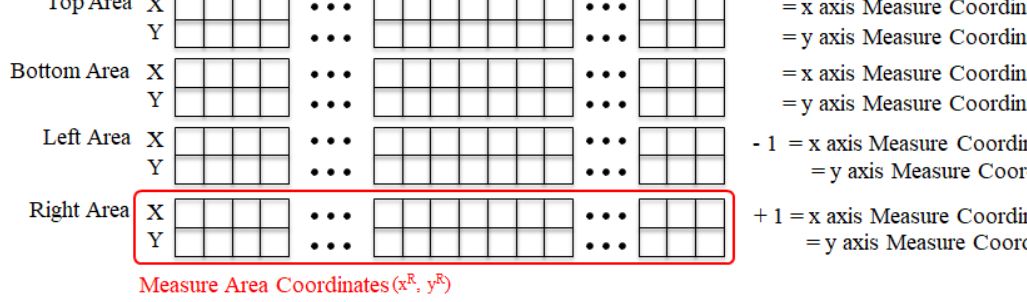
Figure 13. Reference point extraction method (lower-right area). ( a ) Right-hand search area of the circular coordinate array. ( b ) Successful search. ( c ) Search continued. The pseudocode for searching the lower-right area based on the circular coordinate array is shown in Figure 14, where the coordinate array carray[i, len] is used as the input parameter. The values x and y are set to one of coordinates of the given circular coordinate array, as in Line 3, and the pixel value of the coordinate (𝑥, 𝑦) and that of the coordinate (𝑥 + 1, 𝑦) are checked to ensure that they are different. That is, it is checked to ensure it satisfies image_array ((cid:3051),(cid:3052)) ≠ image_array ((cid:3051)(cid:2878)(cid:2869),(cid:3052)) . The position satisfying this condition is de- fined as the reference point (see Line 4 and Figure 13b). If the condition is not satisfied, checking of the next coordinate is performed until end of the given circular coordinate array. Figure 14. Proposed algorithm (reference point check for the lower-right corner). The pseudocode for calculating the difference between the current position’s coordi- nates and the coordinates to be moved to on the lower-right corner based on the circular coordinate array is shown in Figure 16. The difference coordinate ( dx , dy ) and the coordi- nate array carray [ are used as the input parameters. The difference coordinate ( dx , dy ) i , len ] is a parameter for returning the difference between the current position and the next posi- tion moved to. By moving a pixel (right) along the x -axis, the value of dx is set to unity (see Line 1.1). For the y -axis, because the slope fluctuates as indicated by h m in Figure 16a, the range of fluctuation in the y -axis is defined from +3 (maximum) to − 3 (minimum) (see Lines 1.1 and 1.2) such that it can approach 0 ◦ (horizontal) to a maximum of +70 ◦ and a minimum of –70 ◦ . Thus, the candidate ranges of the difference coordinate ( dx , dy ) become ( 1, − 3 ) , ( 1, − 2 ) , . . . , ( 1, 0 ) , ( 1, 1 ) , . . . , and ( 1, 3 ) , and the position (coordinate) for moving is determined by receiving the candidate range from the check_Bottom_Side function.